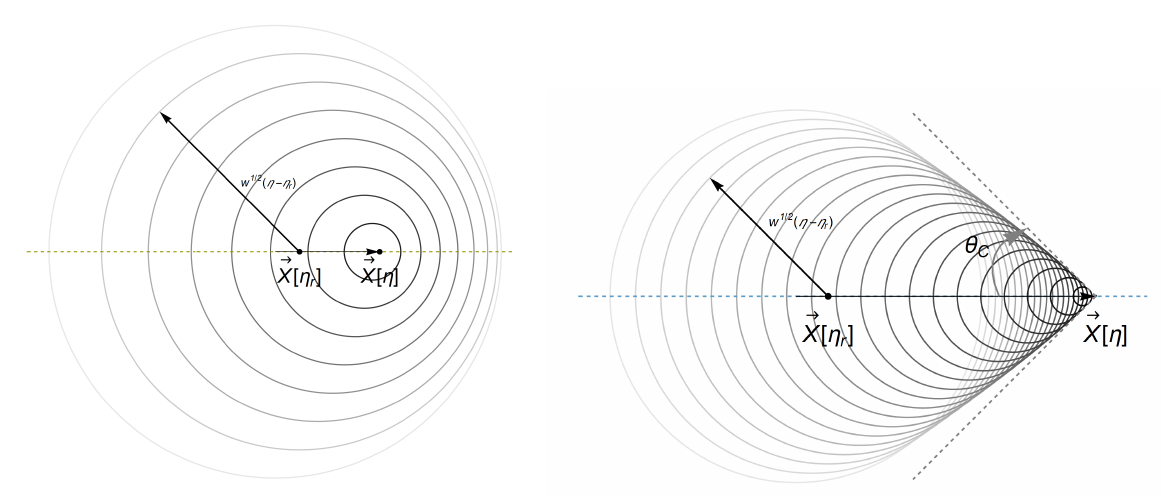
Figure 2. Cherenkov radiation: Huygens’ perspective. These plots show, for some fixed time η , the retarded spatial locations of the point source (points on the two horizontal black arrows) moving along the (cid:98) e 1 axis (dotted horizontal line) strictly towards the right. The current position of the point is the arrow’s tip. Each circle is the wavefront that emanated from the √ √ w = 1/ point (cid:126) X [ η r ] on the horizontal black arrow lying on the former’s center, with radius equal to 3 times the time elapsed η − η r , where η r is the retarded time of that location. Since the further left on the arrow means farther to the past in retarded time, this is why their associated wavefront circles are larger than those centered near the arrow’s tip. Left panel: √ w , basic kinematics indicate it is always outrun by the wavefronts evaluated on When the point source moves slower than √ w , however, no wavefront to its right can outrun it. the (cid:98) e 1 to its right. Right panel: When the point source moves faster than What occurs instead is the wavefronts begin to pile up; the envelope of these circles define the Cherenkov shock wave–this is the constant − η snapshot of the bottom panel in Figure 1–outside of it, no signal can be